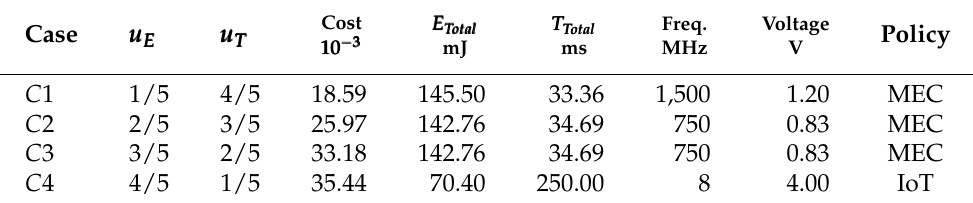
Table 6. Cost coefficients for energy and time variation for Application